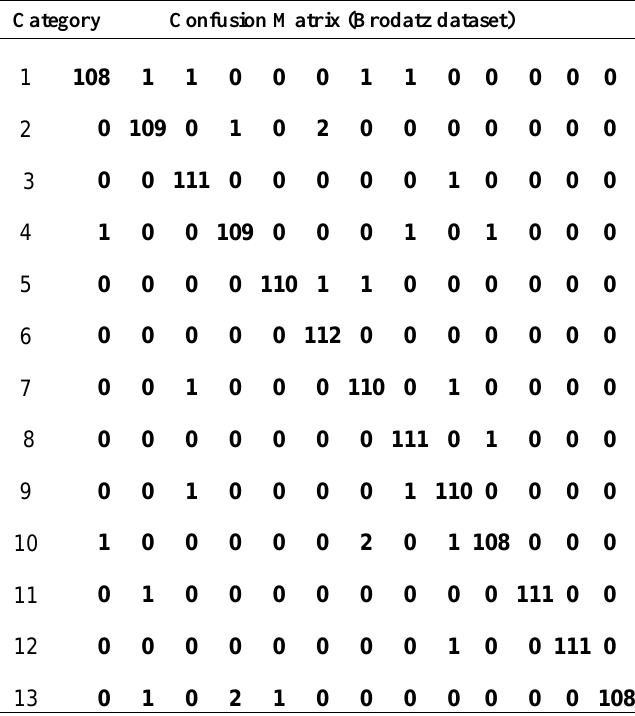
Table 7. Confusion matrix based on Brodatz